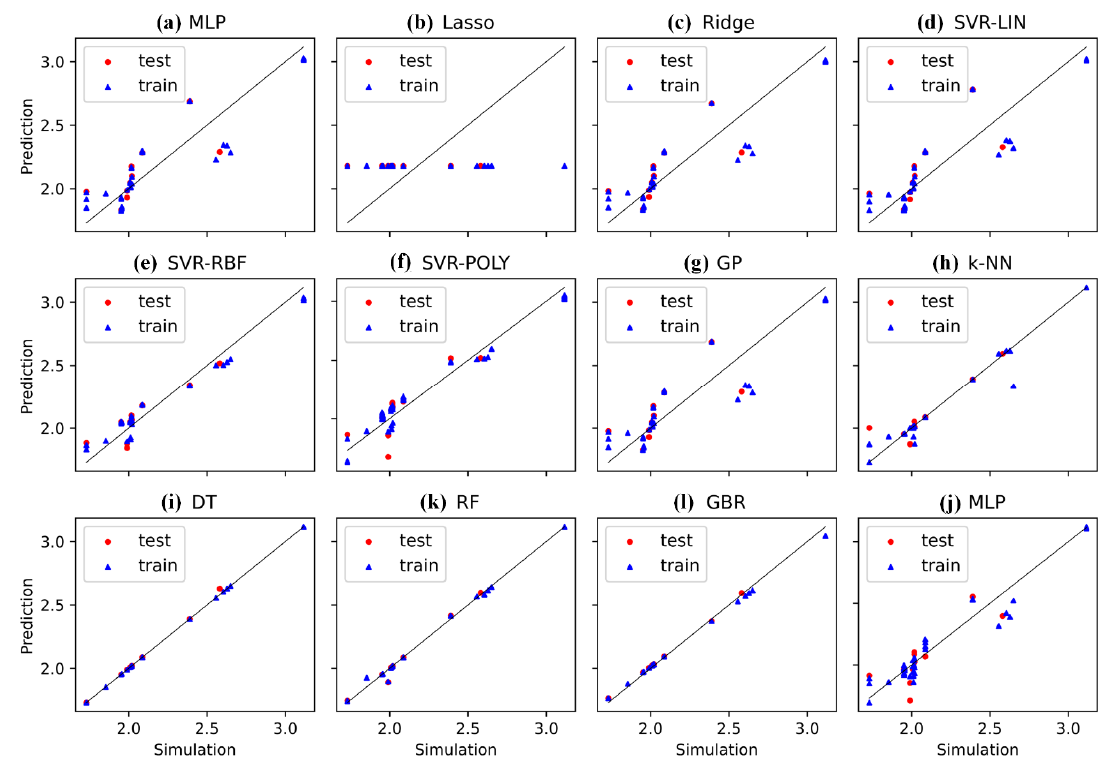
Figure 10. Simulation versus predicted values for thermal conductivity in Poiseuille flow model of the LJ fluid, being the output of 12 different algorithms ( a – l ). Data points include both training and test data. The 45° identity line denotes the perfect match.